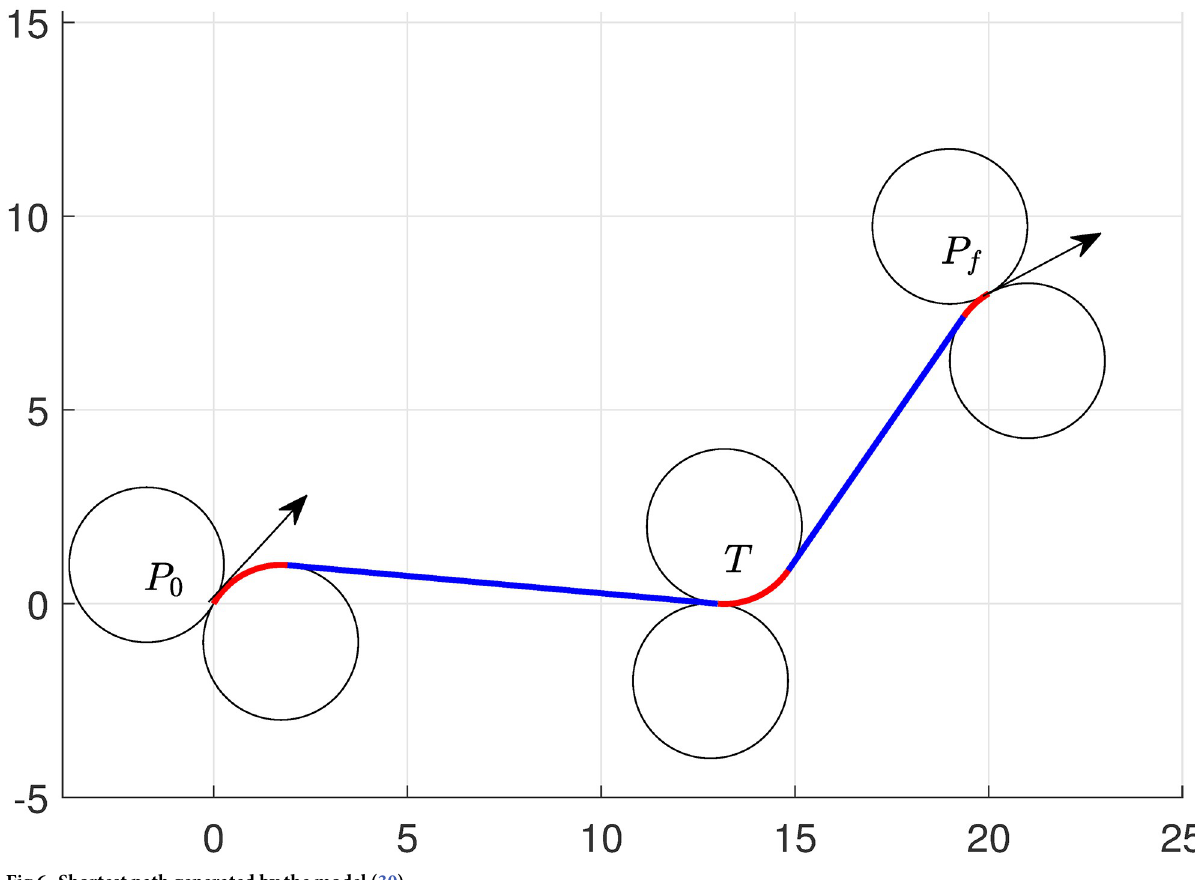
Fig 6. Shortest path generated by the model